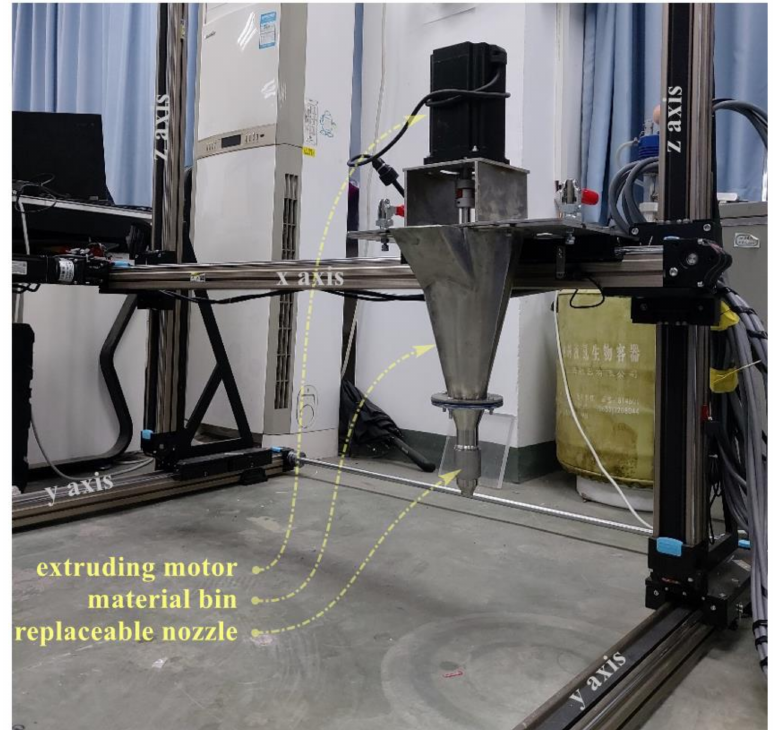
Figure 2. The 3D printer and the